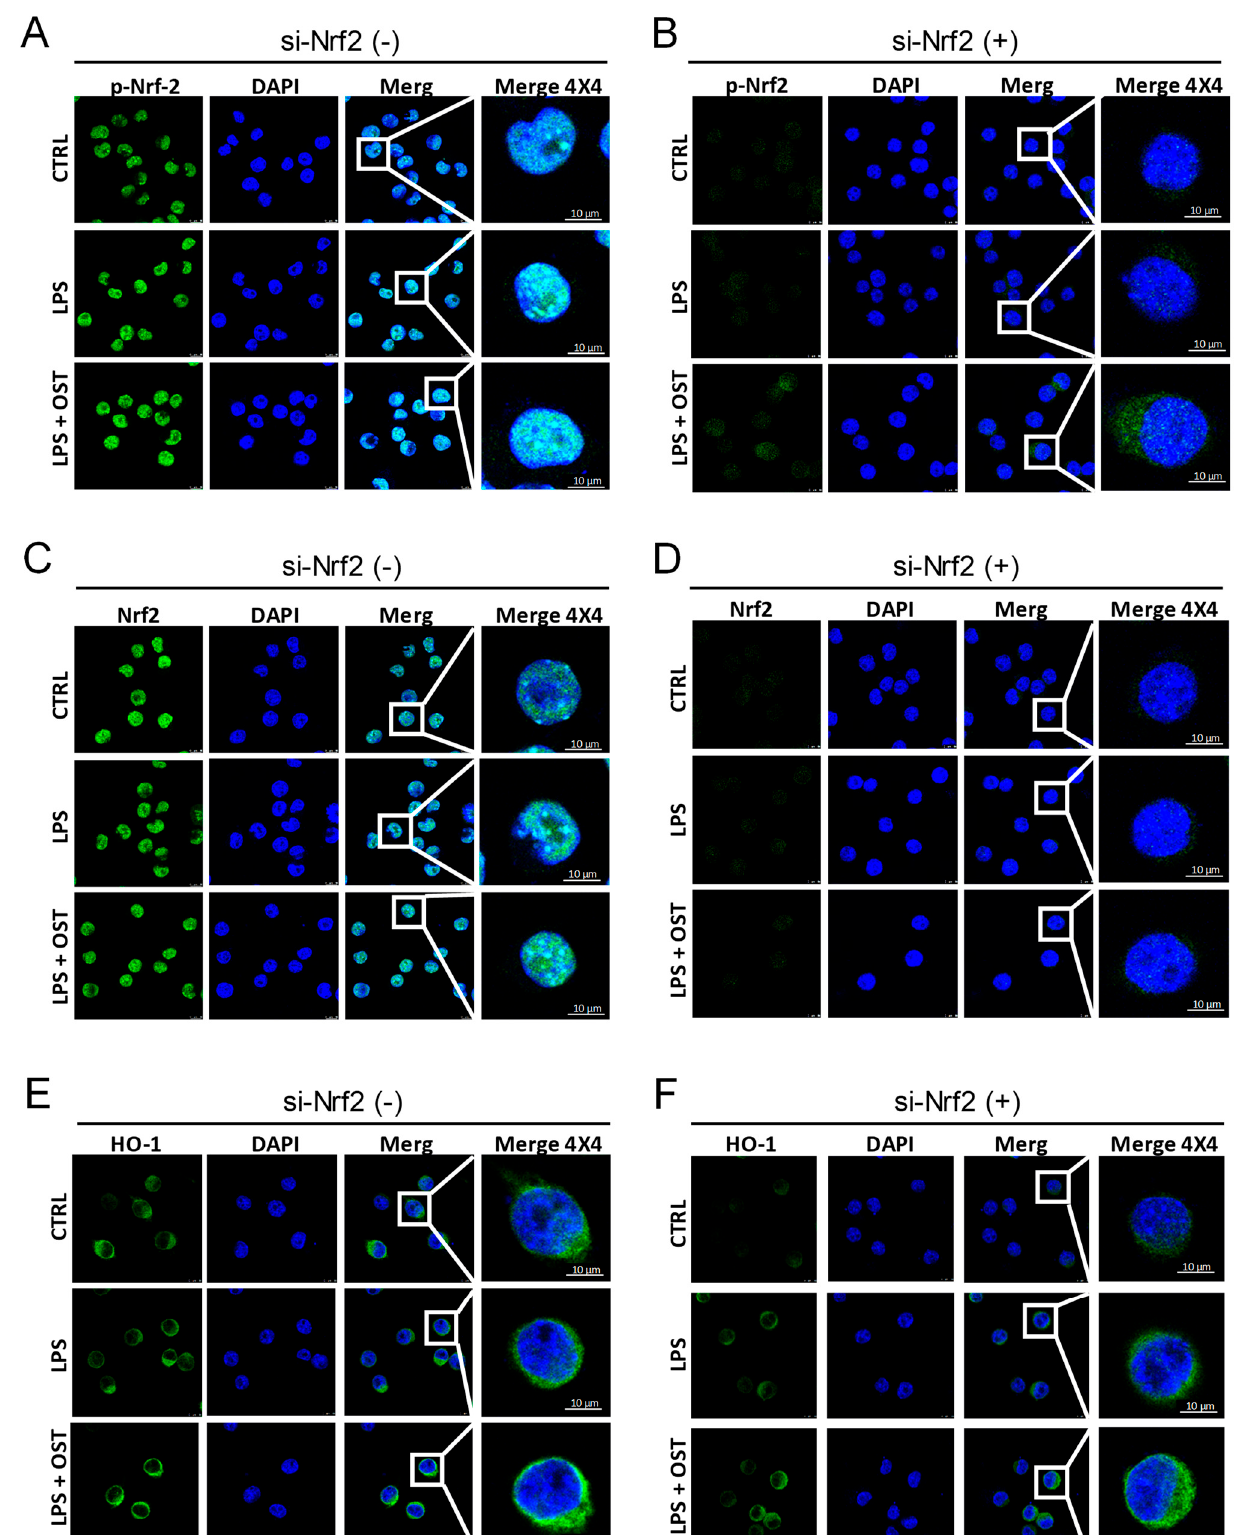
Figure 2. Illustrative images of immunofluorescence staining showed the effect of OST on the expression of p-Nrf2 in LPS-stimulated ( A ) BV2 cells and ( B ) Nrf2 siRNA-treated BV2 cells. The expression of Nrf2 in LPS-stimulated ( C ) BV2 cells and ( D ) Nrf2 siRNA-treated BV2 cells. The expression of HO-1 in LPS-stimulated ( E ) BV2 cells and ( F ) Nrf2 siRNA-treated BV2 cells.